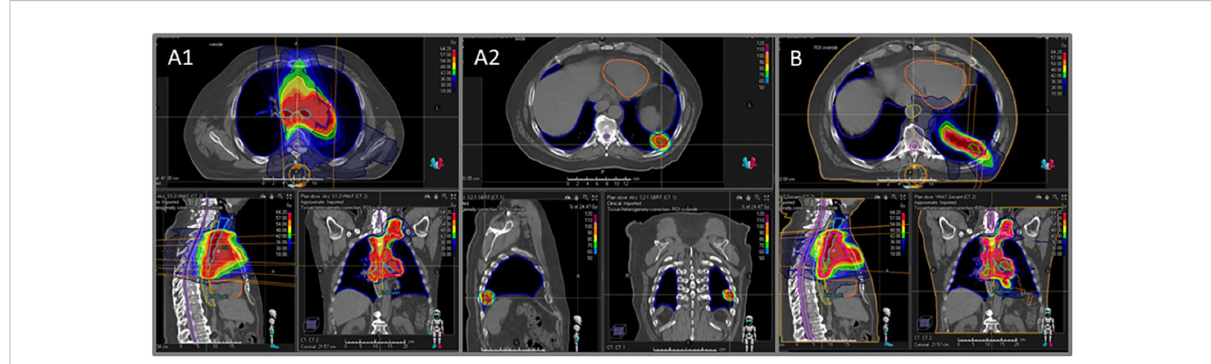
FIGURE 2 Illustration of dose color wash plans comparing conventionally fractionated radiotherapy to the mediastinal lymph nodes (MLN, A1 ) and stereotactic radio-therapy to the primary (SBRT, A2 ) ( A1 + A2 : SBRT+MLN approach) versus conventionally fractionated VMAT for both the primary and MLN including the ‘ bridging area ’ ( B : VMAT only approach). This is an exemplary case of a 62-year old man with locally advanced adenocarcinoma NSCLC stage III that underwent de fi nitive concurrent platinum-based